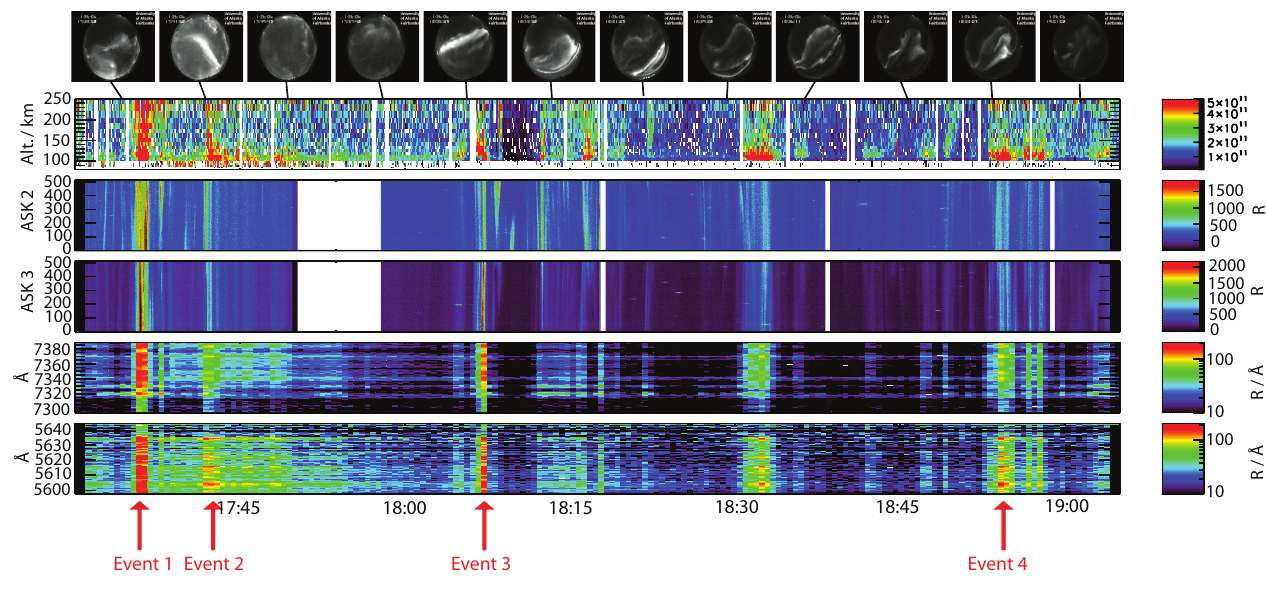
Fig. 2. Overview of the interval 17:30UT to 19:00UT on 26 January 2006. Top: Images from the University of Alaska All-Sky imager, panel 1: ESR electron density vs altitude, panel 2 and panel 3: ASK2 and ASK3 keograms, panel 4: spectrographic data from SIF O + (7319), panel 5: spectrographic data from SIF O + (5620). The events discussed in Sect. 4 are marked with red arrows. 2